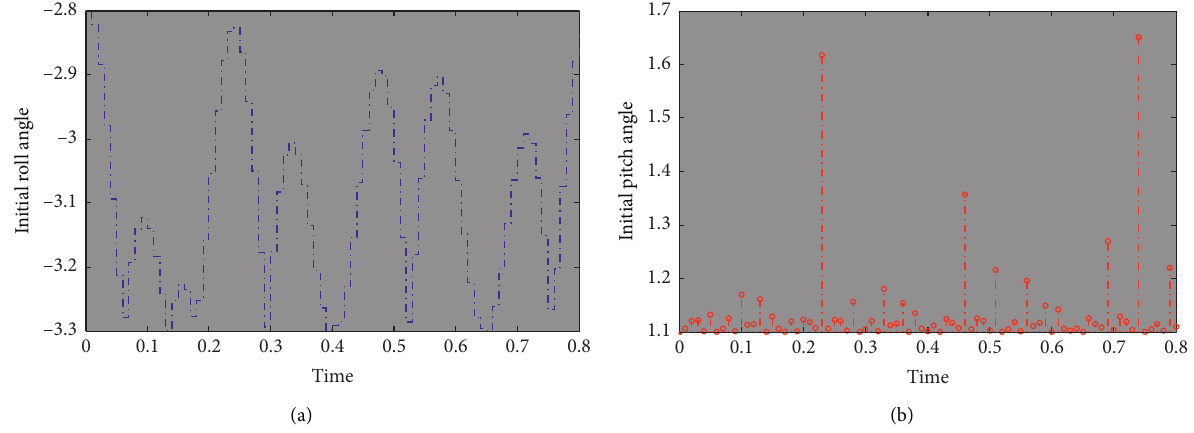
Figure 11: Action initial attitude angle data: (a) initial roll angle; (b) initial pitch